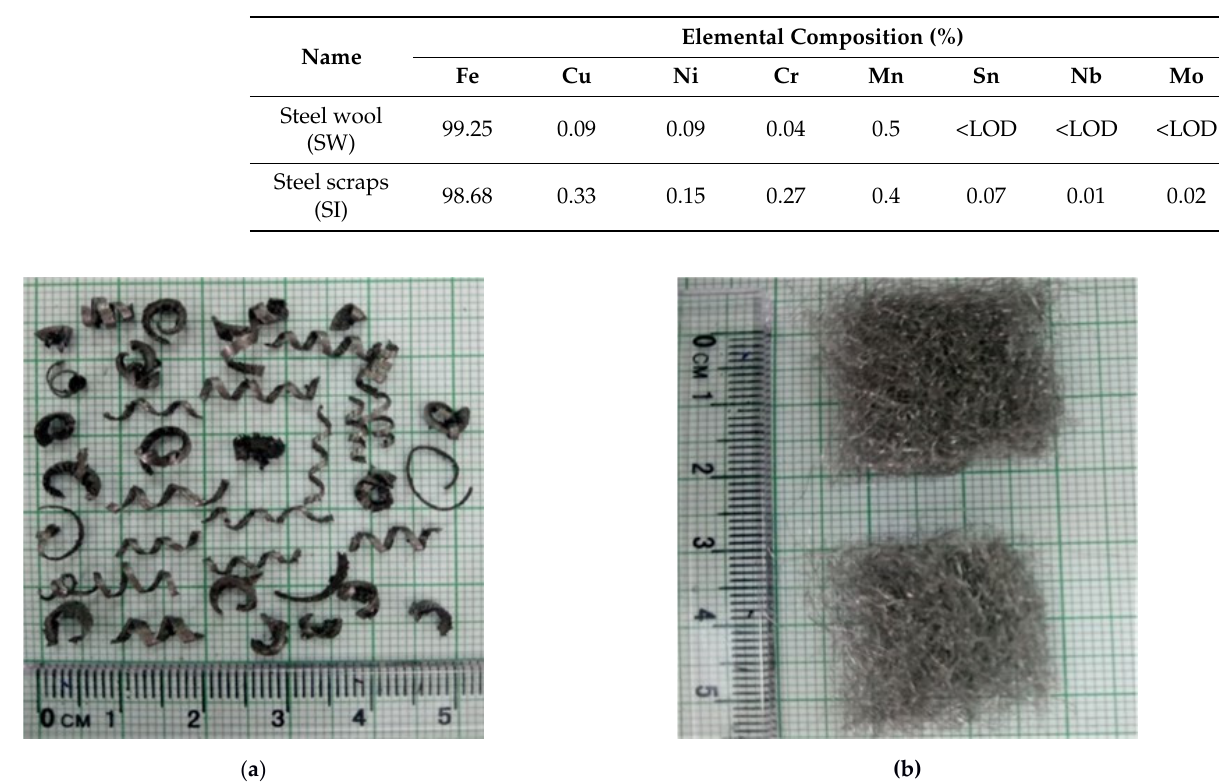
Table 1. Elemental composition of tested Fe 0 materials. LOD stands for the lowest concentration at which an element can be detected.